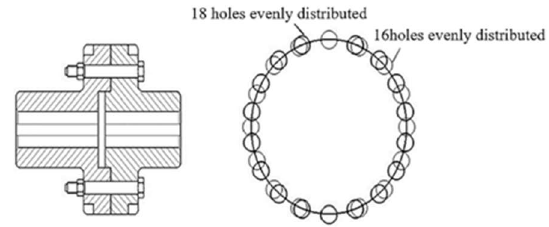
Figure 5. Load flange and load coupling principle diagram.